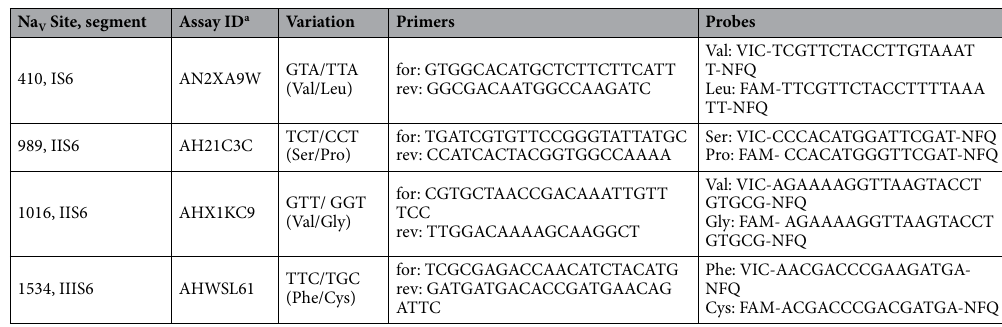
Table 3. Primers and probes for TaqMan SNP genotyping qPCR assays for kdr mutations in Aedes aegypti . a Identification of the customized TaqMan SNP Genotyping Assay (Thermo Fischer).